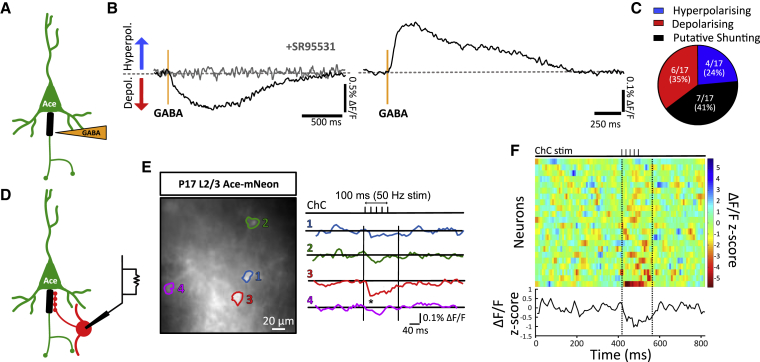
Axo-axonic Plasticity Matches GABAergic Polarity(A) Schematic showing iontophoresis experiment. A pipette containing GABA was placed near the AIS of a pyramidal neuron expressing Ace2N-mNeon.(B) Example traces obtained from imaging somatic responses to iontophoretic GABA application (orange area) at the AIS of two different cells. Left, a depolarizing response that is blocked by the application of 10 μM SR95531 (GABAzine). Right, example trace showing a hyperpolarizing response.(C) Classification of responses into hyperpolarizing (blue), depolarizing (red), and putative shunting (black) for all cells tested.(D) Schematic showing experimental logic: ChCs were patch-clamped to evoke APs, and responses were imaged from the soma of nearby pyramidal cells expressing Ace2N-mNeon.(E) Left, example image of Ace2N-mNeon cells, with somas outlined in different colors. Right, change in fluorescence of corresponding cells following ChC stimulation (top; 5 APs, 50 Hz) (∗denotes time-locked event 3x >baseline standard deviation in cell 3). Vertical lines denote start and end of expected response period, allowing up to 50 ms for decay of GABAergic responses (Figure 2I).(F) Heatmap showing Z scores of fluorescence responses following ChC stimulation for all 22 pyramidal cells tested. Mean Z score across all cells is shown below.See also Figures S4 and S6.